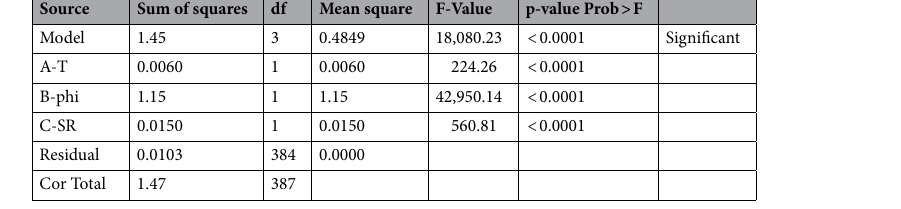
Table 4. ANOVA-RSM linear model.